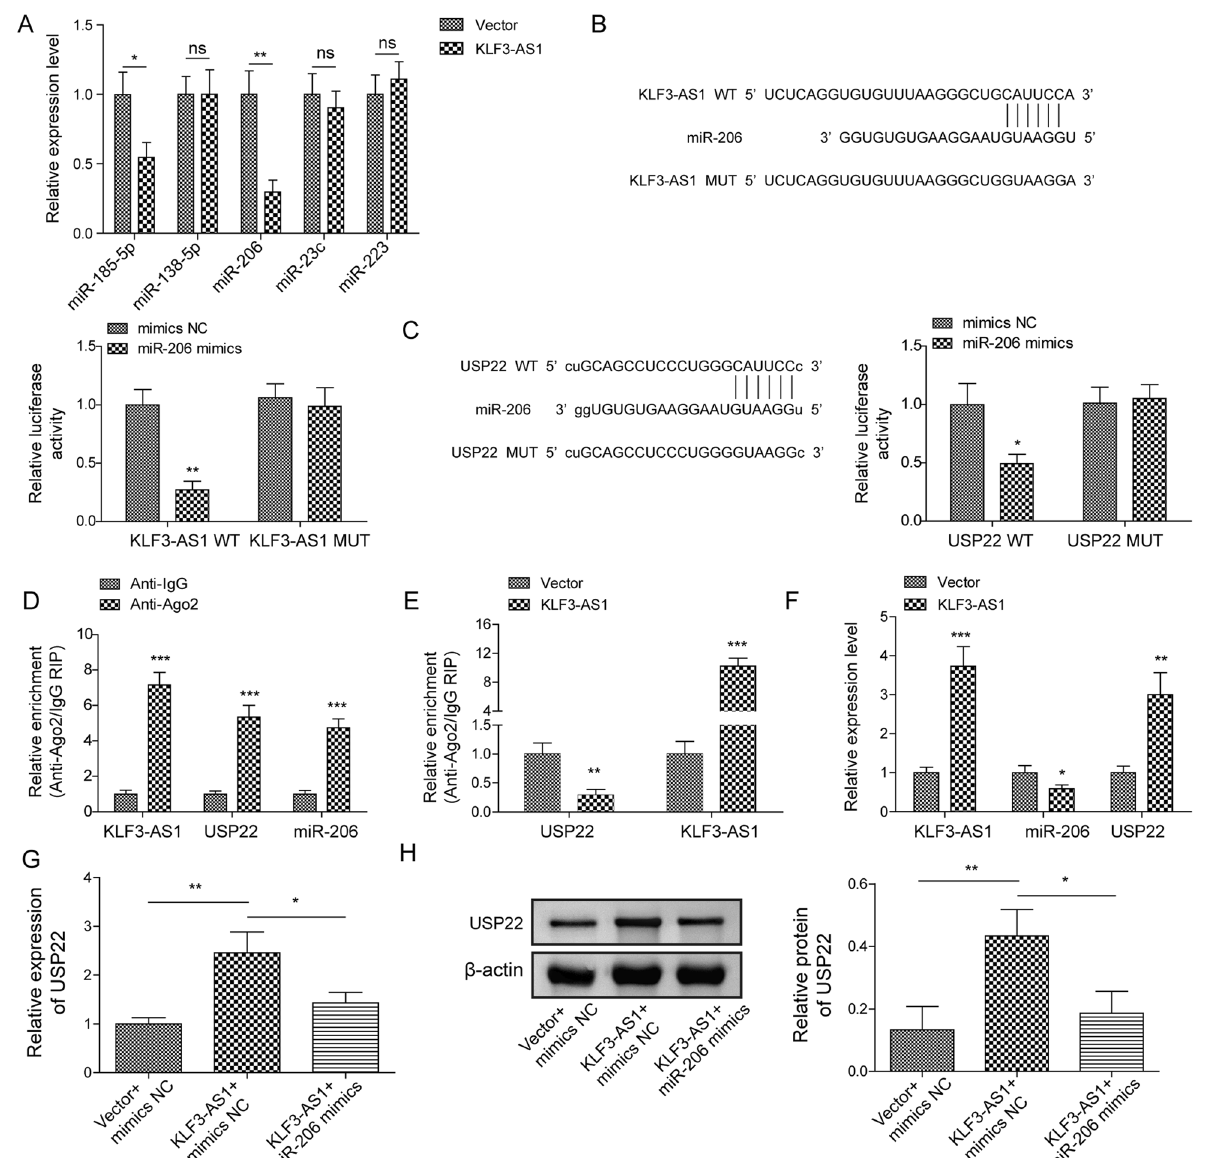
Fig. 5 The interaction of KLF3-AS1, miR-206and USP22. A Bioinformatics predicted the binding sites of several miRNAs with KLF3-AS1. Cells were transfected with pcDNA-KLF3-AS1 or control vector, then miRNAs levels were detected. B , C Luciferase activity examined using luciferase reporter assay. D Anti-Ago2 RIP assay in BV-2 cells was performed, then KLF3-AS1, miR-206 and USP22 mRNA associated with Ago2 were measured. E Cells were transfected with pcDNA-KLF3-AS1, RIP assay was then carried out. And the enrichment of KLF3-AS1 and USP22 was detected. F KLF3-AS1, miR-206 and USP22 mRNA levels were measured in cells transfected with pcDNA-KLF3-AS1. G , H Cells were transfected with KLF3-AS1 overexpression plasmid, vector or miR-206 mimic, then qRT-PCR ( G ) or western blot ( H ) was performed for measuring USP22. Values were expressed as mean SD of three separate determinations in the in vitro assays. *P < 0.05, **P < 0.01, ***P < ±